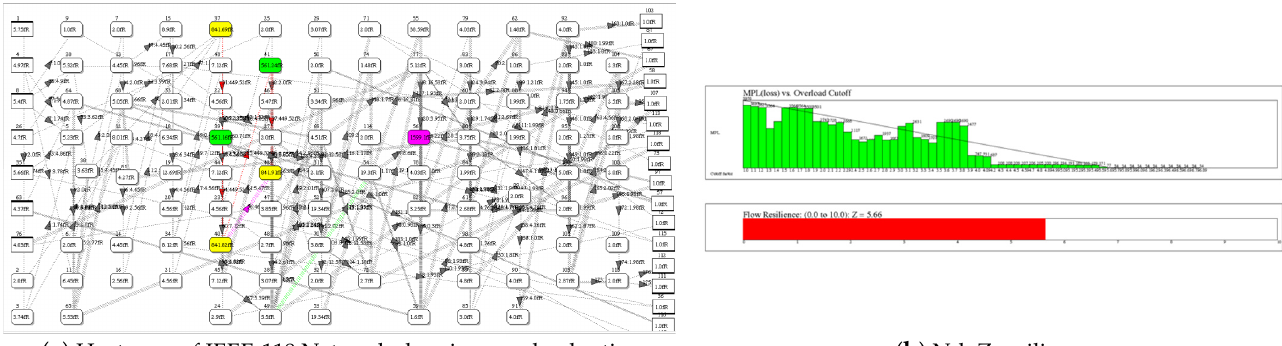
Figure 8. Resilience of the IEEE-118 power grid test network. ( a ). A colored heat map of flow ratios obtained from removal of one link and re-routing. This suggests “hot spots” in the network that are likely to overload when stressed. ( b ). Calculating flow resilience Z = 5.66 out of 10.0.